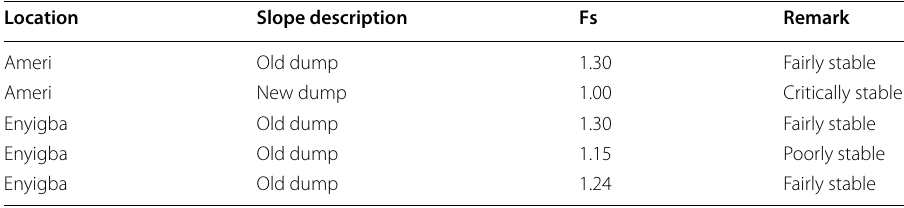
Table 4 Stability analysis